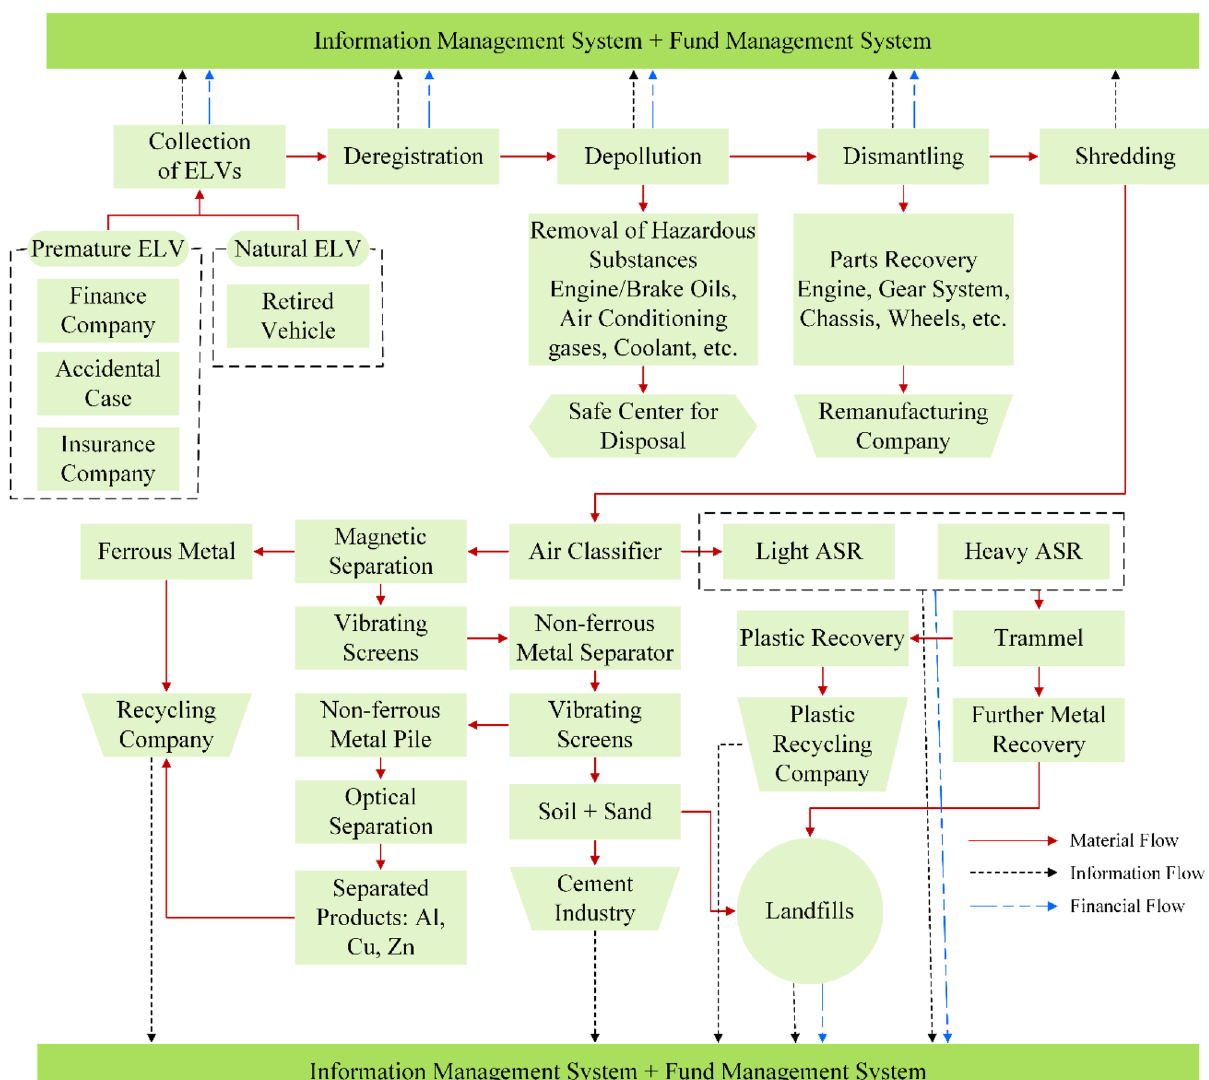
Figure 2. Proposed framework for ELV recycling. Adopted and redrawn from authors own source 25